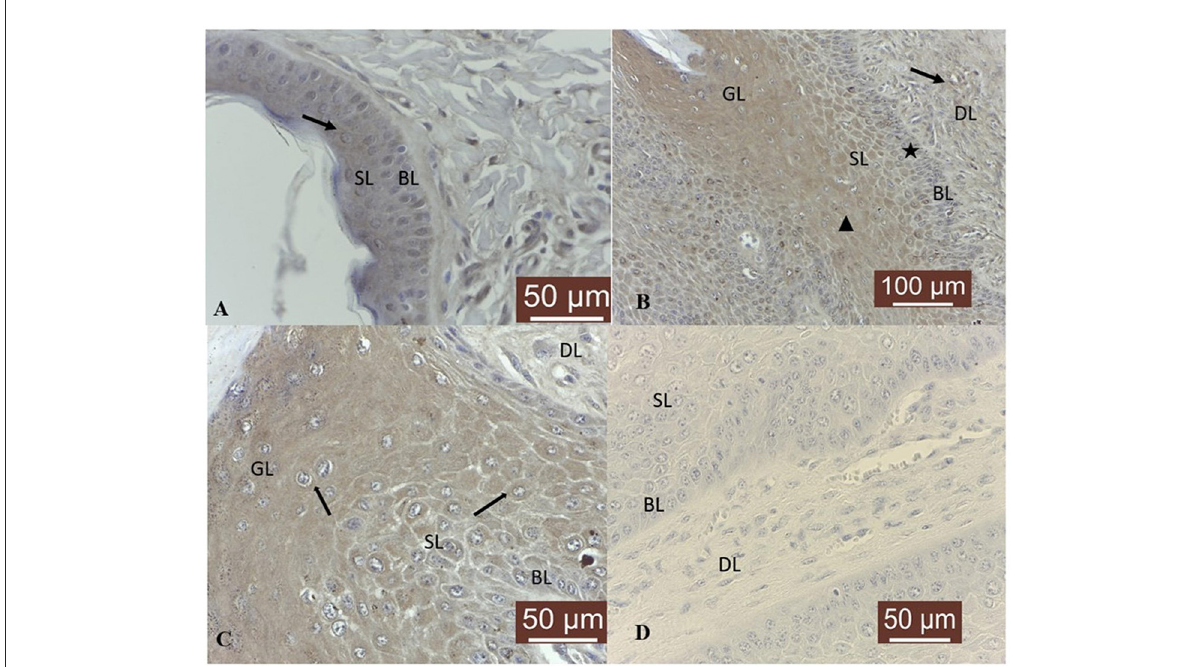
FIGURE2 MMP-2 immunostaining in bovine normal skin and fibropapillomas: (A) Cytoplasmic and perinuclear expression (black arrow) in normal skin keratinocytes from basal (BL) and spinosum (SL) epithelial layers; 40X. (B) Fibropapilloma: MMP-2 is expressed in keratinocytes from basal (BL), spinosum (SL) and granular (GL) epithelial layers (black arrowhead), although a weaker immunoreactivity is noted in the basal cell layer (black star); note a moderate positivity in cytoplasm of SL and GL cells and in fibroblast cells (black arrow) from dermal layer (DL); 20 X. (C) MMP-2 is strongly expressed in a fine light brown granular cytoplasmic (black arrows) and perinuclear pattern; 40 X. (D) Negative control: fibropapilloma with the first antibody anti-MMP-2 omitted and incubated with secondary antibody did not stain; 40 X.